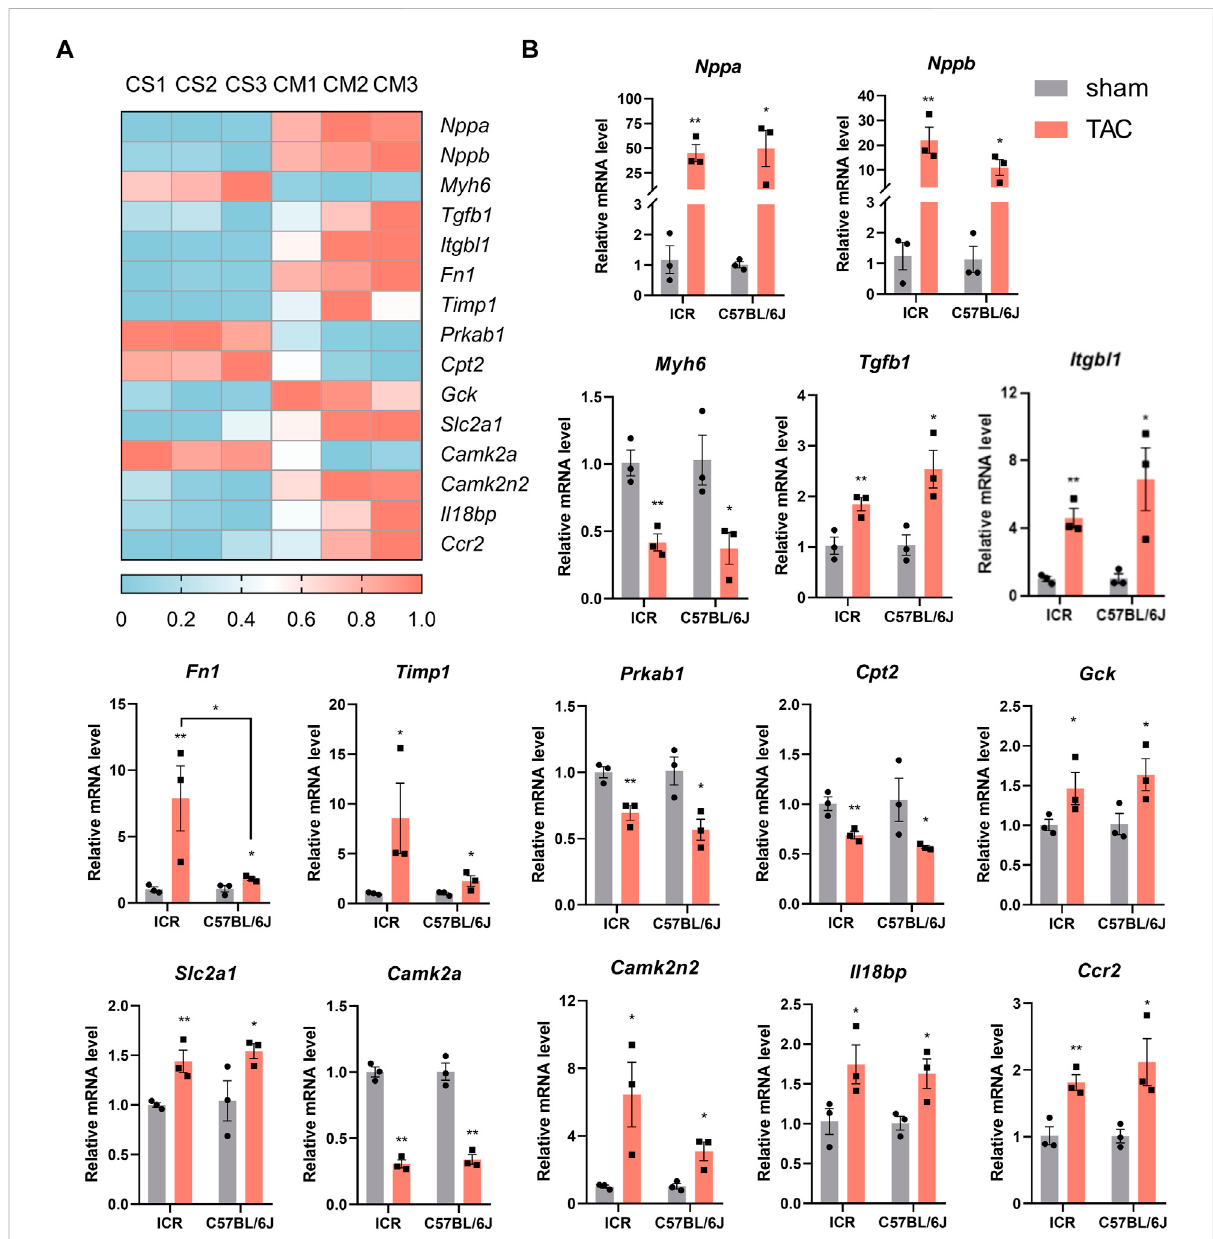
Pathological gene-expression alteration in heart tissue of ICR and C57BL/6J mice 4 weeks post-TAC. (A) Heatmap of differentially expressed genes in C57BL/6J mice by RNAseq. CS: C57BL/6J sham; CM: C57BL/6J model. N = 3. (B) Real time quantitive PCR veri fi cation of the expression levels of 15 selected genes in both ICR and C57BL/6J mice. Relative mRNA levels are normalized to Gapdh , values are shown as mean ± SEM, N = 3 each. * p < 0.05, ** p < 0.01 vs. their own